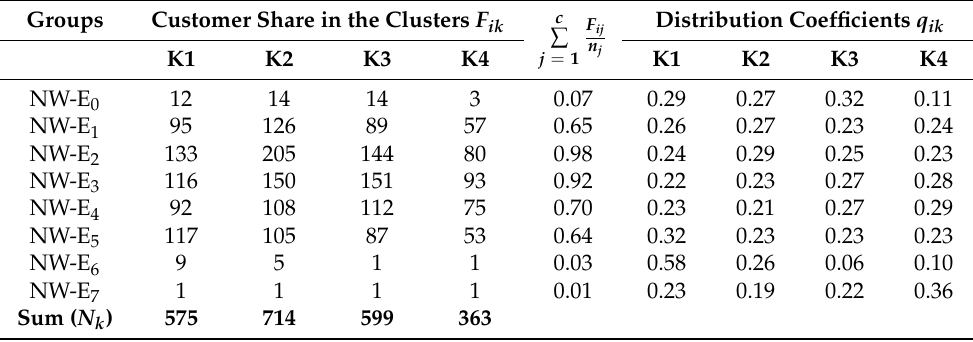
Table 5. Customer shares in the cluster ( F ik ) and distribution coefficients ( q ik ) for the groups of customers of the northwest area (NW) in the four resulting clusters (database 2017).